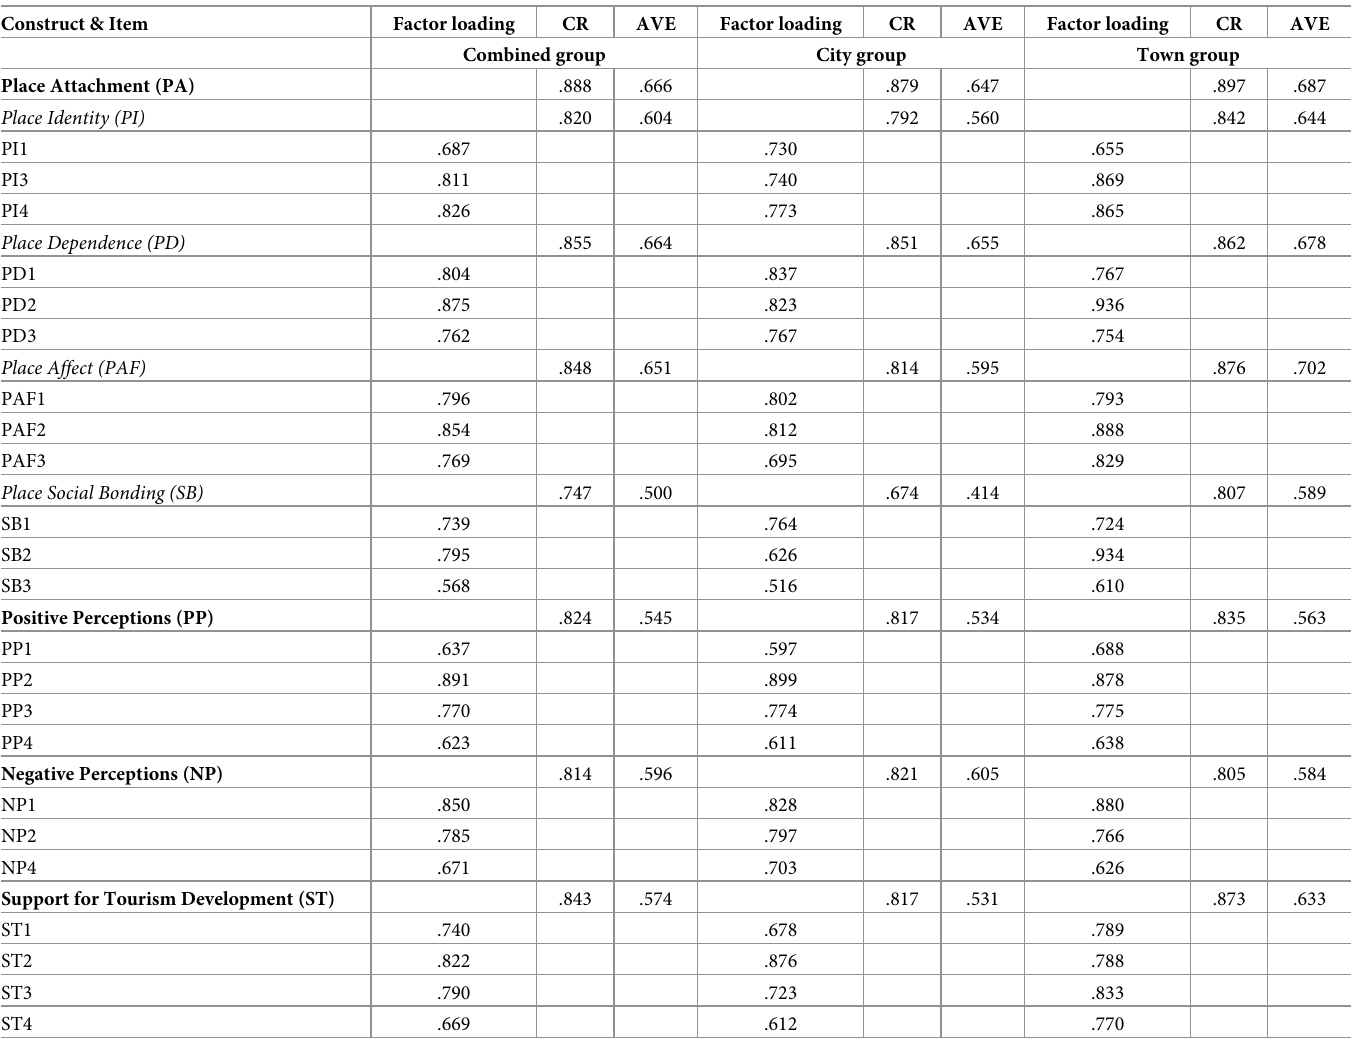
Table 5. CFA results for measurement models of constructs.